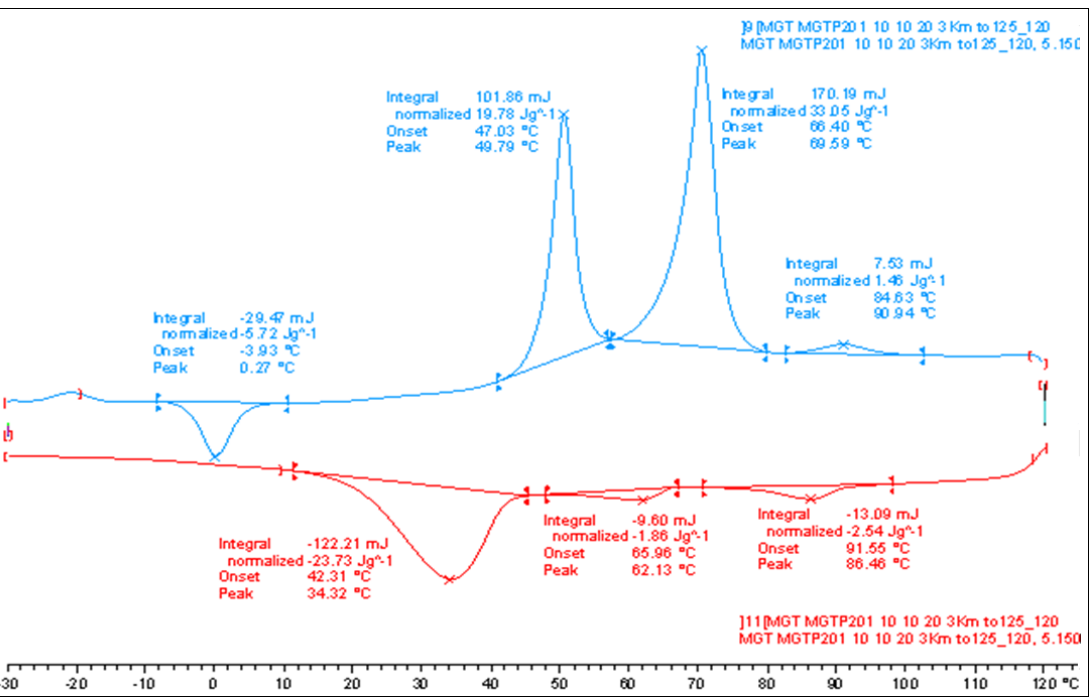
(−1.86) 34.2 (−23.73) x